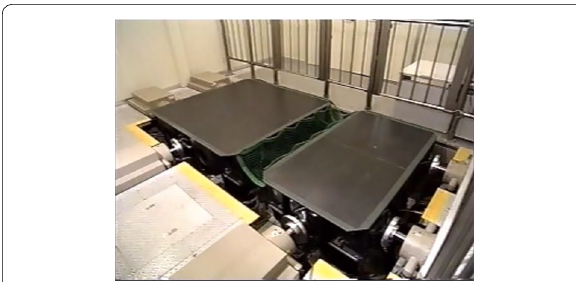
Figure 8 IMV vehicle seat comfort assessment system